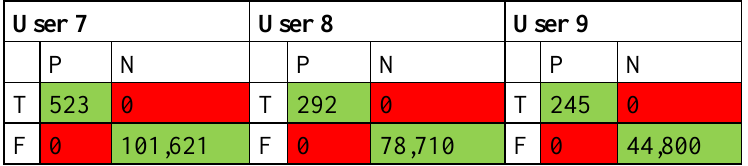
Table 4. Confusion matrix for the R wave III.